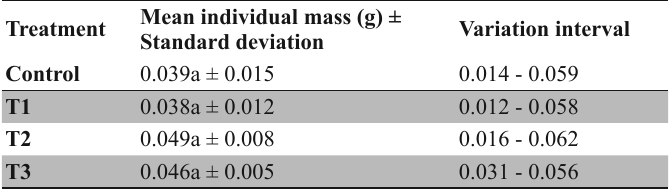
Body mass of larvae (g)* of the blow fl y Chrysomya putoria (Wiedemann, 1830) (Diptera, Calliphoridae) after four treatments with different concentrations of ampicillin, reared in a climatic chamber (30 °C day and 28 °C night, 70 + 10 % RH and 14 h photoperiod).